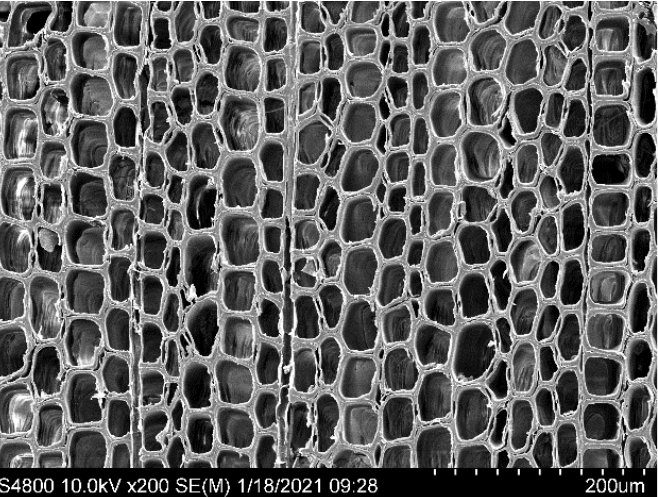
Figure 1. Example of cellular cross section structure of softwood [Masson pine ( Pinus massoniana Lamb.), shot via Hitachi S-4800@10 kV, WD = 8 mm].